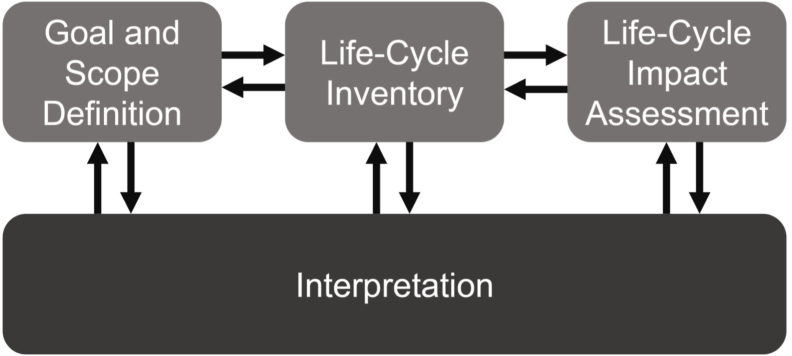
The ISO standards structure for an LCA (ISO, 2006a, ISO, 2006b).